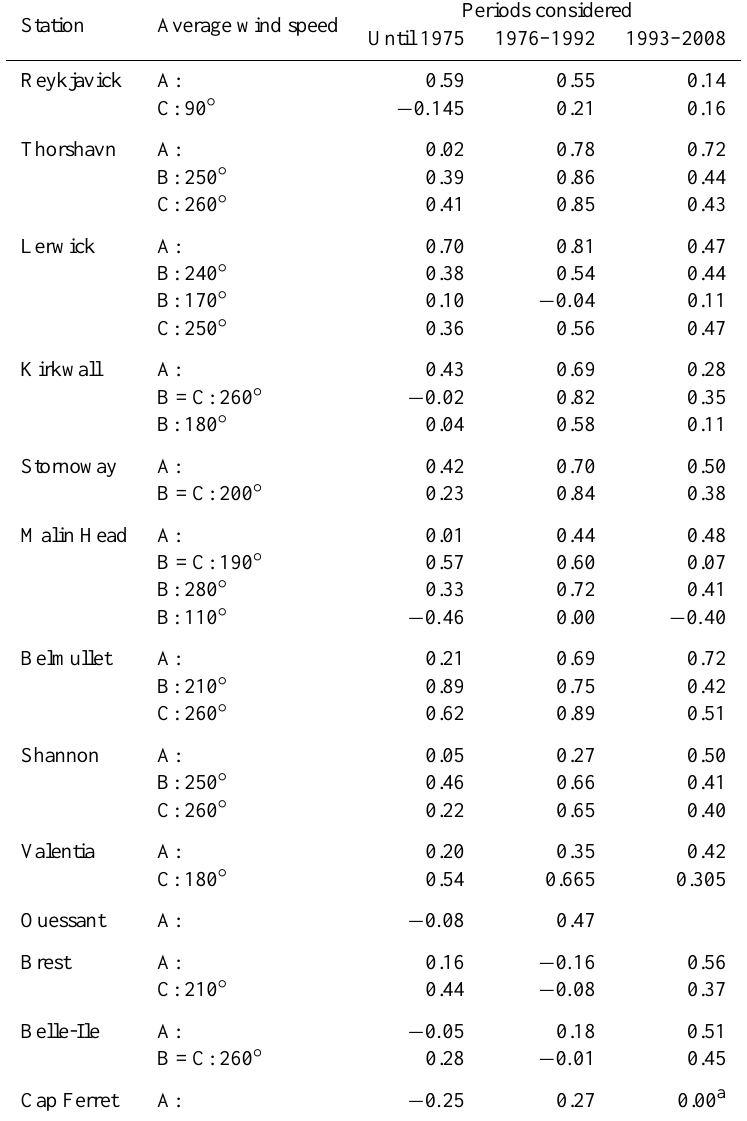
Table 3. Correlation coefficients between wind speed (A: average from all directions; B: the sum of positive projections upon certain dominant wind directions deduced from Fig. 6; C: the sum of positive projections upon the dominant wind direction deduced from angular distribution of energy flux), and NAO index during the cold season (October to March) along a transect of meteorological stations in the NE